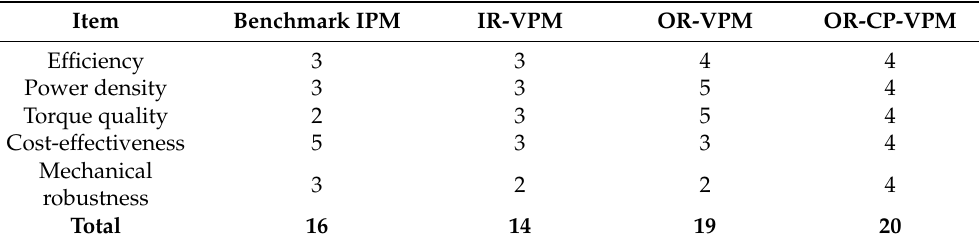
Table 3. Evaluations on the proposed